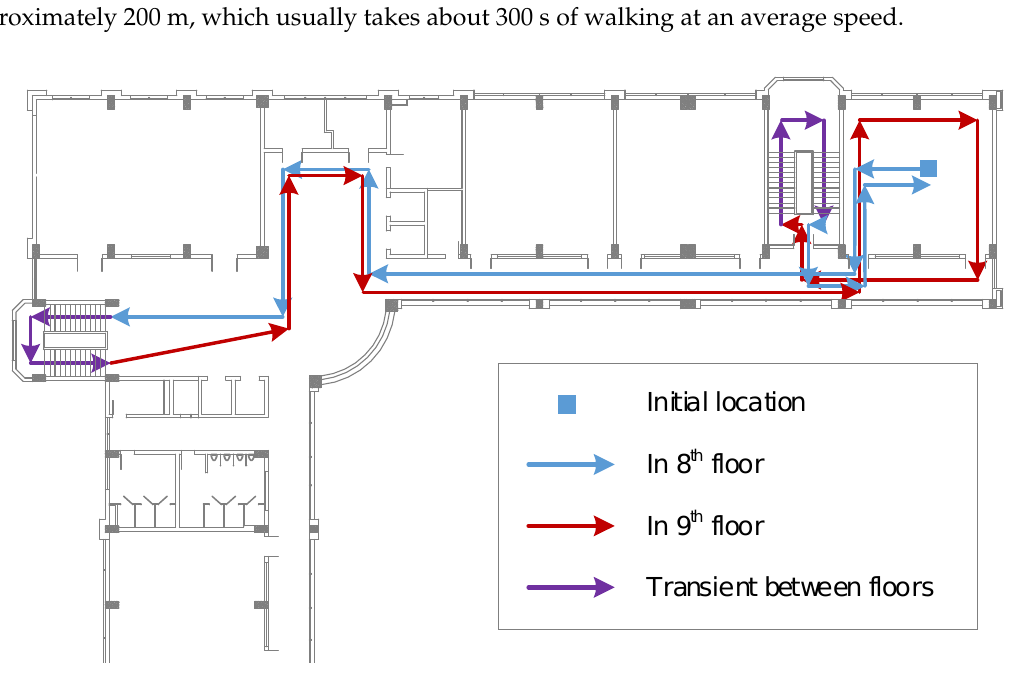
Figure 7. Moving path and checkpoints in two floors. Table 2. Participating devices in the testing scenarios.